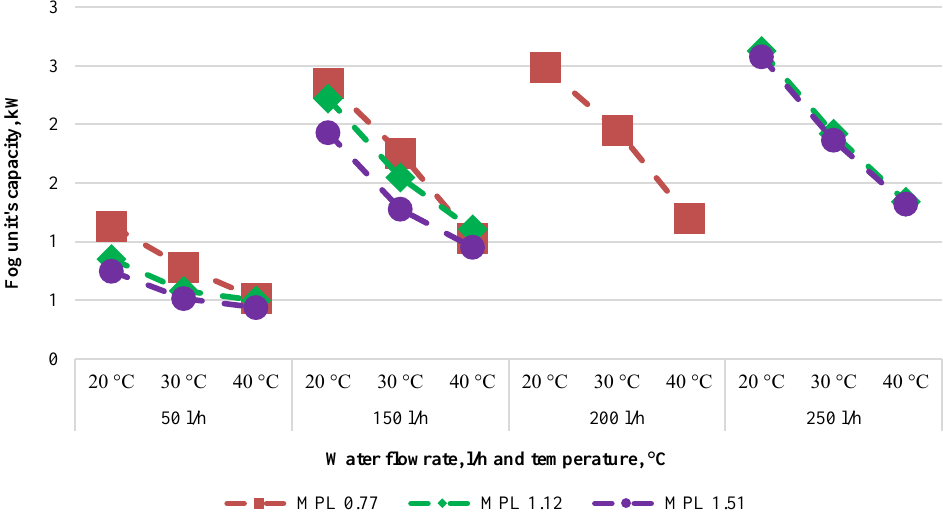
Fig. 3. Effects of nozzle size, sprayed water amount and temperature on condenser’s capacity after the fog unit. Growth of sprayed water flowrate promotes decrease of flue gas temperature and increase of the fog unit’s capacity. It is possible to increase the promoted technology’s capacity